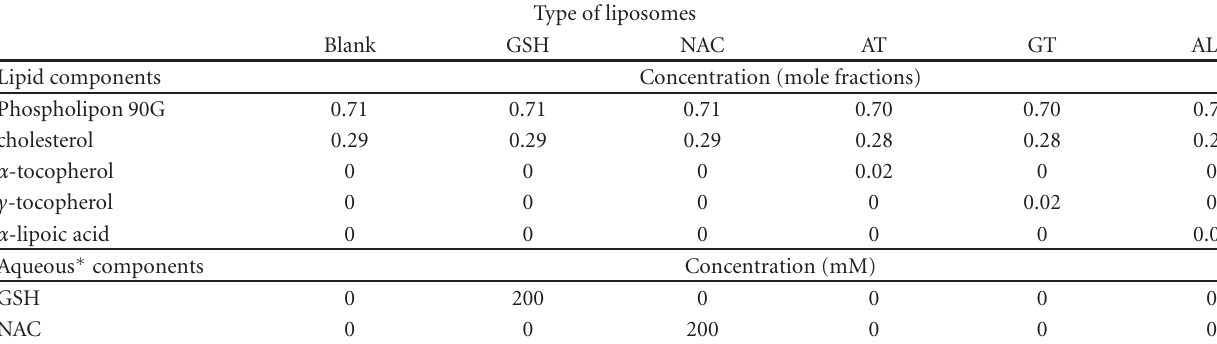
Table 1: Liposome